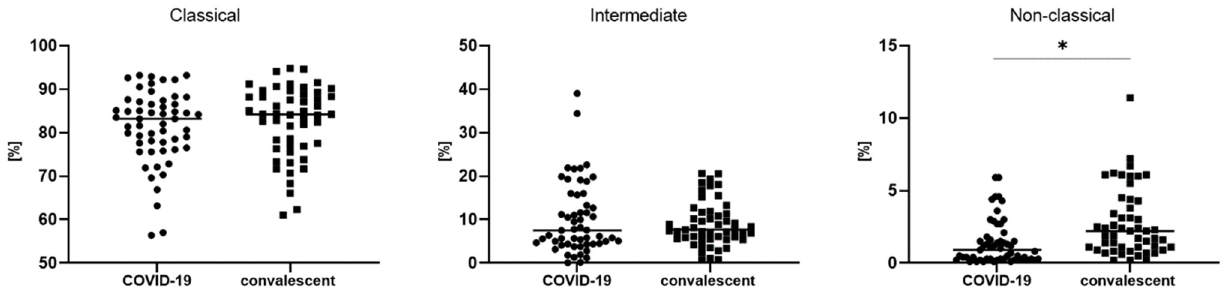
Figure 2. The differences in three types of monocytes—classical, intermediate and non-classical monocytes—between COVID-19 and convalescent patients. Graphs show the median values ( − ), * p < 0.05. Graphs show the median values (Min–Max). Significant differences in the cell proportion between COVID-19 and convalescent patients in the Mann–Whitney U test presented as * ( p < 0.05).